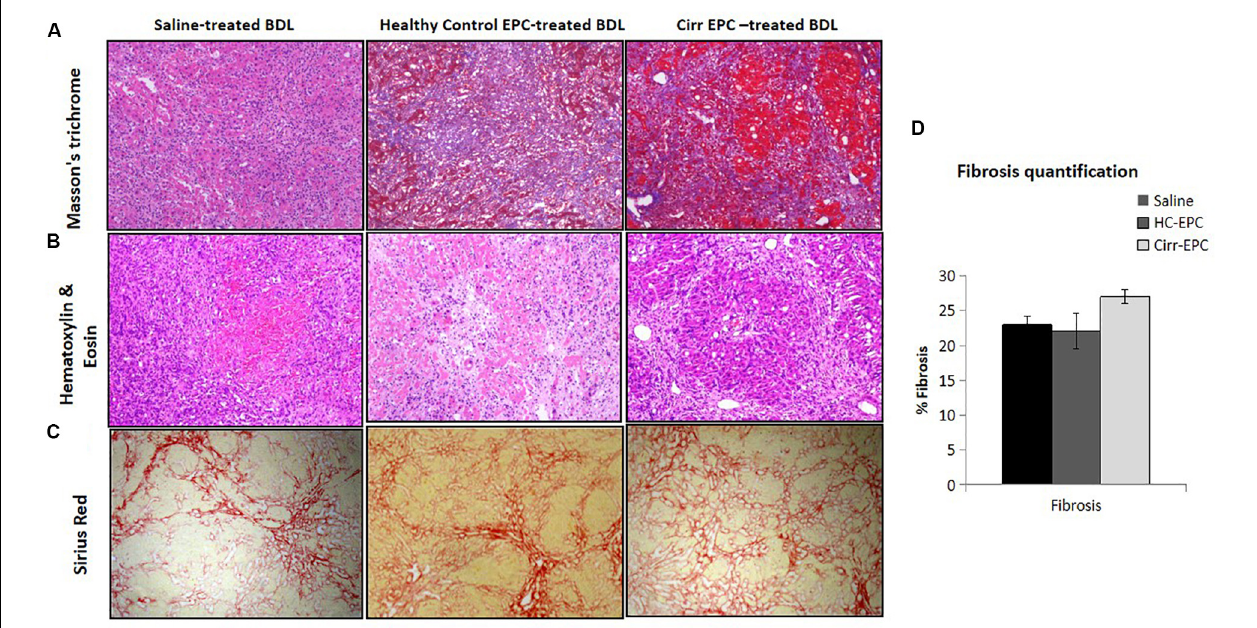
FIGURE 4 | Assessment of liver fibrosis (10x) in saline-treated BDL, healthy control (HC), and cirrhotic (cirr) EPC-transplanted BDL rats by (A) Masson’s trichome staining, (B) H and E staining, (C) Sirus red staining, and (D) fibrosis